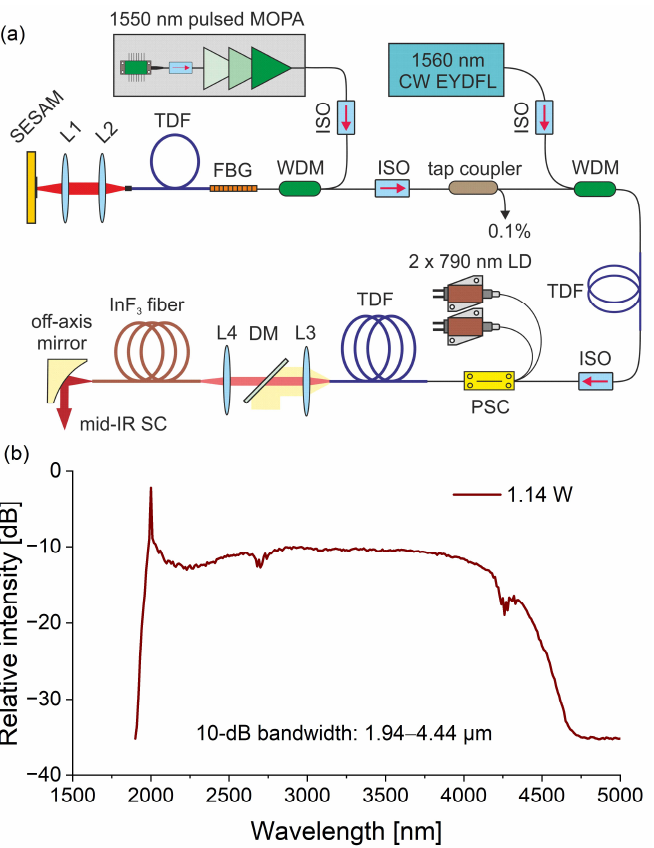
Figure 13. Experimental setup of SC generation ( a ). In order: semiconductor saturable absorber mirror (SESAM), fiber Bragg grating (FBG), wavelength division multiplexer (WDM), MOPA–Master Oscillator Power Amplifier, Er 3+ :Yb 3+ -doped fiber ring laser (EYDFL), laser diode (LD), Tm 3+ -doped fiber (TDF), pump and signal combiner (PSC), lenses (L1–L4), optical isolator (ISO), and dichroic mirror (DM). SC spectrum generated at the output power of 1.14 W ( b ). Adopted with permission from [123]. Copyright 2021, Optica Publishing Group.